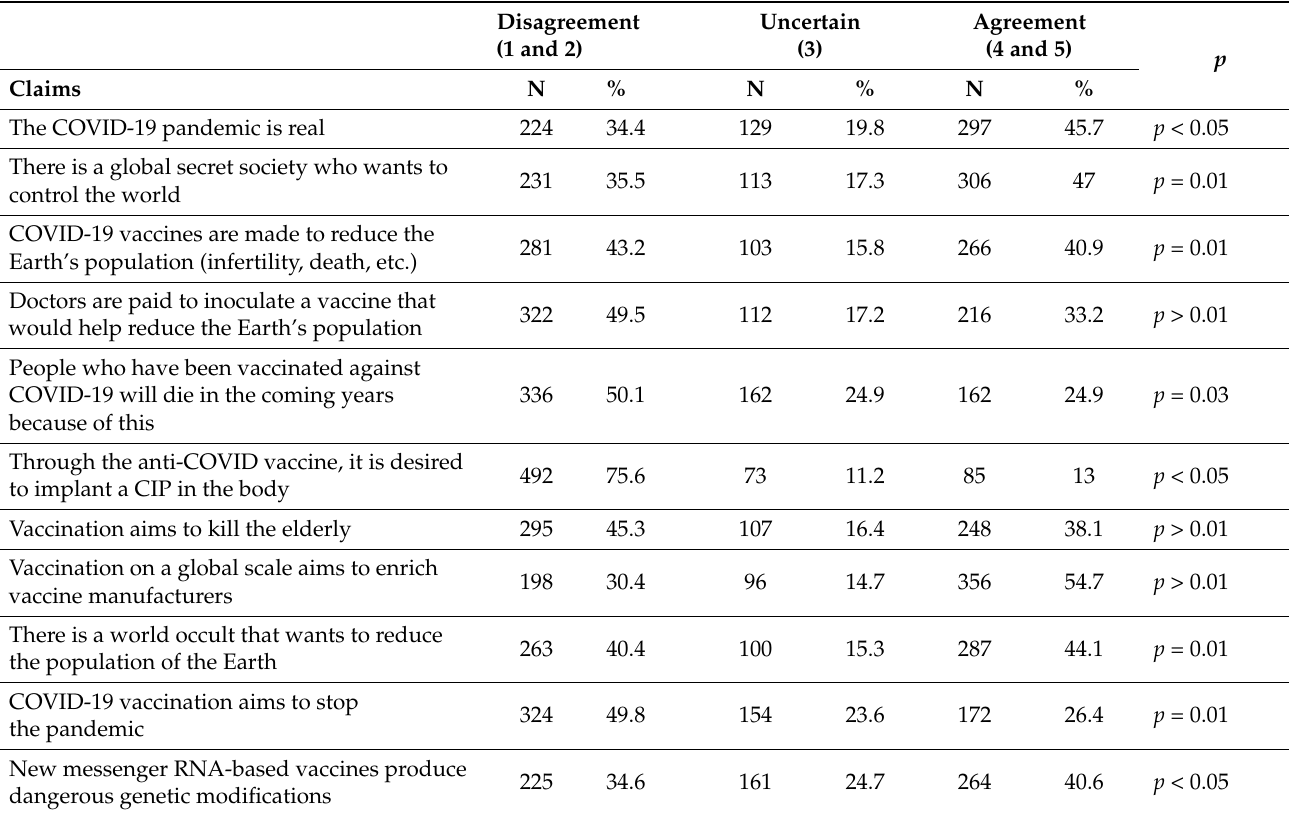
Table 3. The faction by the survey participants of the statements of the type “fake